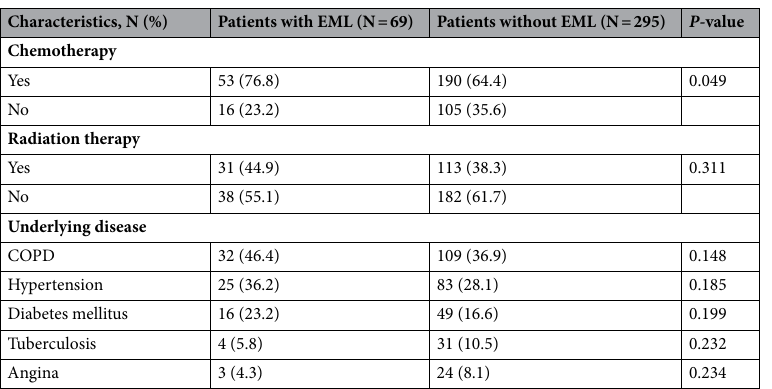
Table 1. Characteristics of NSCLC patients according to EML. BMI body mass index, COPD chronic obstructive pulmonary disease, ECOG PS Eastern Cooperative Oncology Group performance status, EGFR epidermal growth factor receptor, EML endobronchial metastatic lesion, IQR interquartile range, NSCLC non-small cell lung cancer, SqCC squamous cell carcinoma, y age. a 11 (3 vs. 8) patients with non-small cell carcinoma, 2 (1 vs. 1) patients with pleomorphic carcinoma, and 1 (0 vs. 1) patient with spindle cell carcinoma. b 2 patients with the G719 mutation in exon 18 and one patient with the S768I mutation in exon